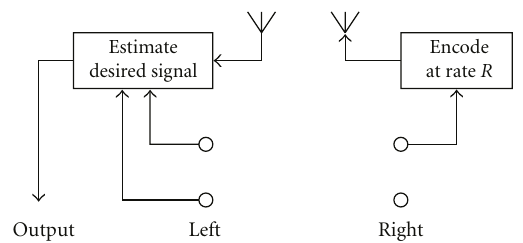
Figure 2: One right ear microphone signal is transmitted at a rate R . At the left ear, the desired signal is estimated from the received signal and the local microphone